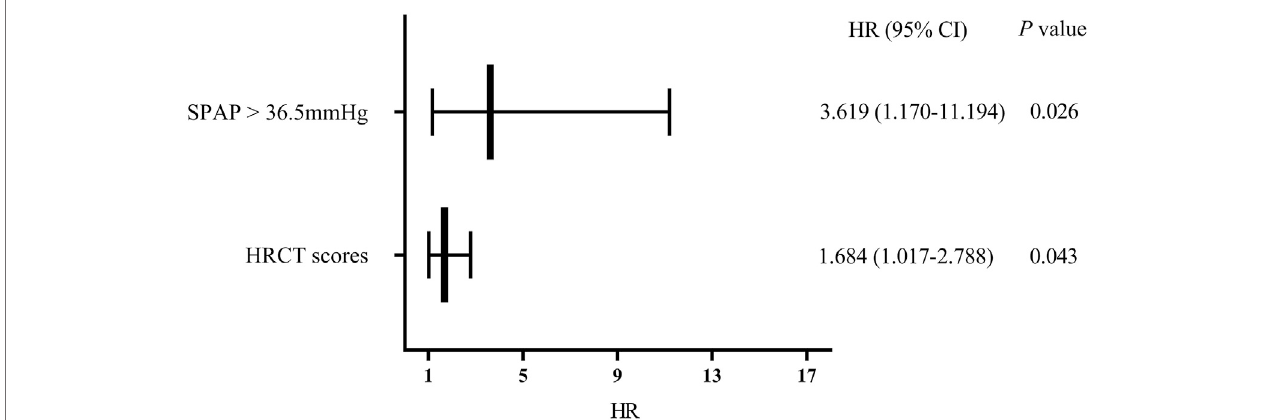
FIGURE 4 | Multivariate regression analysis of mortality; Abbreviations: SPAP, systolic pulmonary artery pressure; HRCT: high-resolution computed tomography; HR, hazard ratio. Cox regression analysis suggested that SPAP > 36.5 mmHg and HRCT scores were independent risk factors for mortality in patients with PF-ILD ( p (cid:1) 0.026, 0.043 respectively).